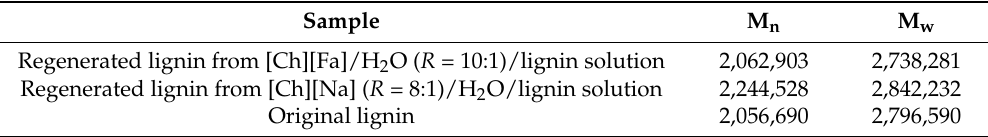
Table 5. The number averaged (M n ) and weight averaged molecular weight (M w ) of samples. Sample